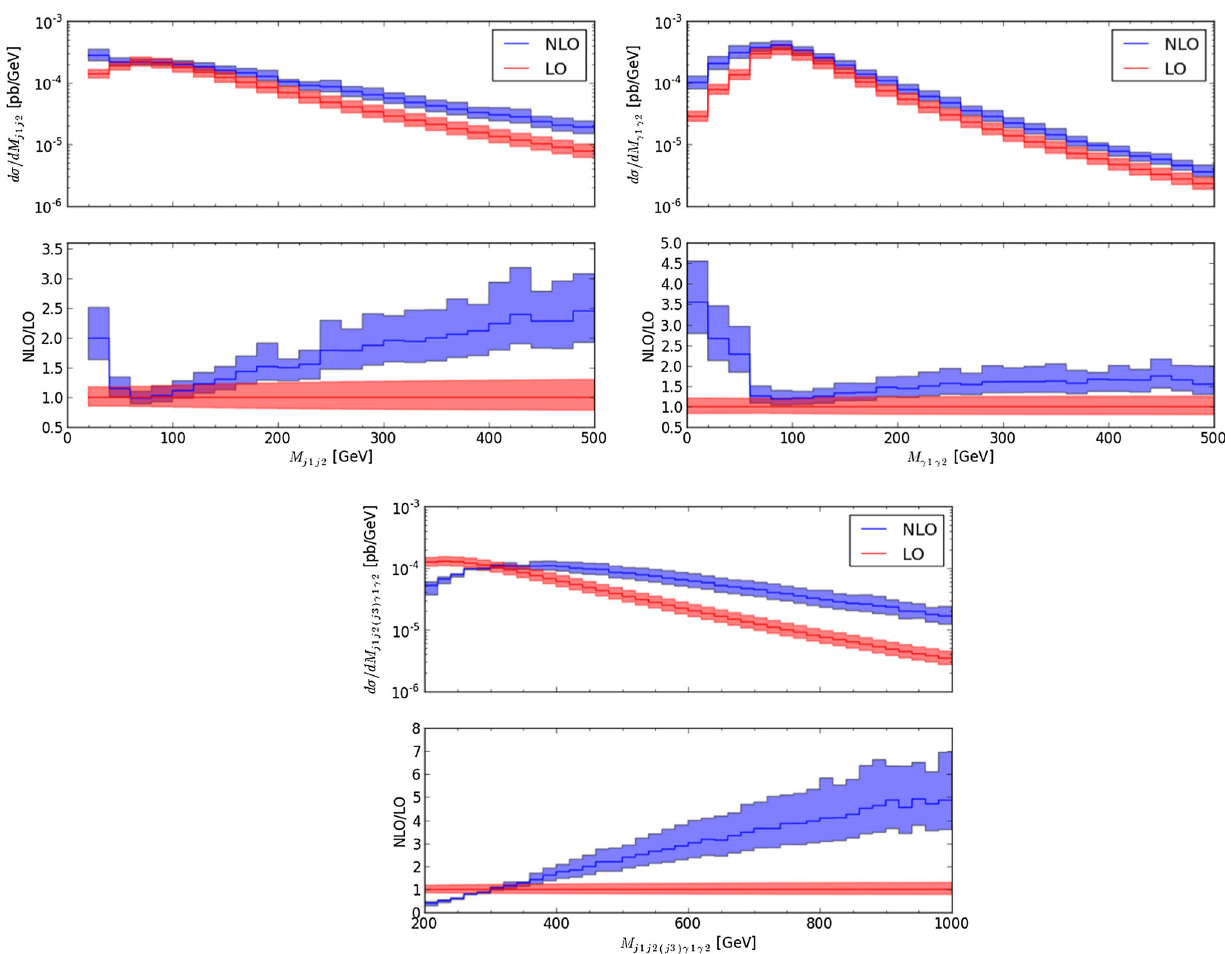
Fig. 4 Invariant mass distributions of the two leading jets (upper left), the two photons (upper right) and the total invariant mass